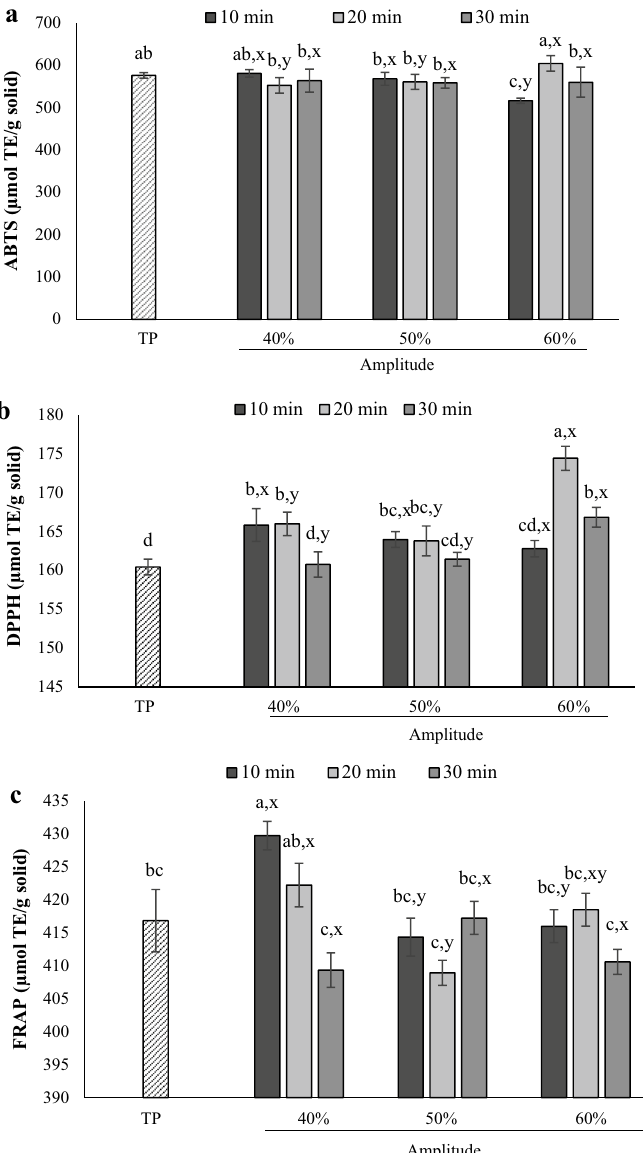
Figure 2. Antioxidant activity of protein extracted from Bombay locust by ultrasound-assisted process under different amplitudes (40, 50, 60%) and ultrasonication times (10, 20, 30 min) in comparison with those from typical extraction process (TP). ABTS radical scavenging activity (ABTS) ( a ), DPPH radical scavenging activity (DPPH) ( b ), Ferric reducing antioxidant power (FRAP) ( c ). Bars represent the standard deviation (n = 3). a,b,c indicated significant differences in values between all data ( p ≤ 0.05). x,y,z indicated significant differences of data comparing in the same ultrasonication time ( p ≤ 0.05). Data obtained were analyzed by using One-way